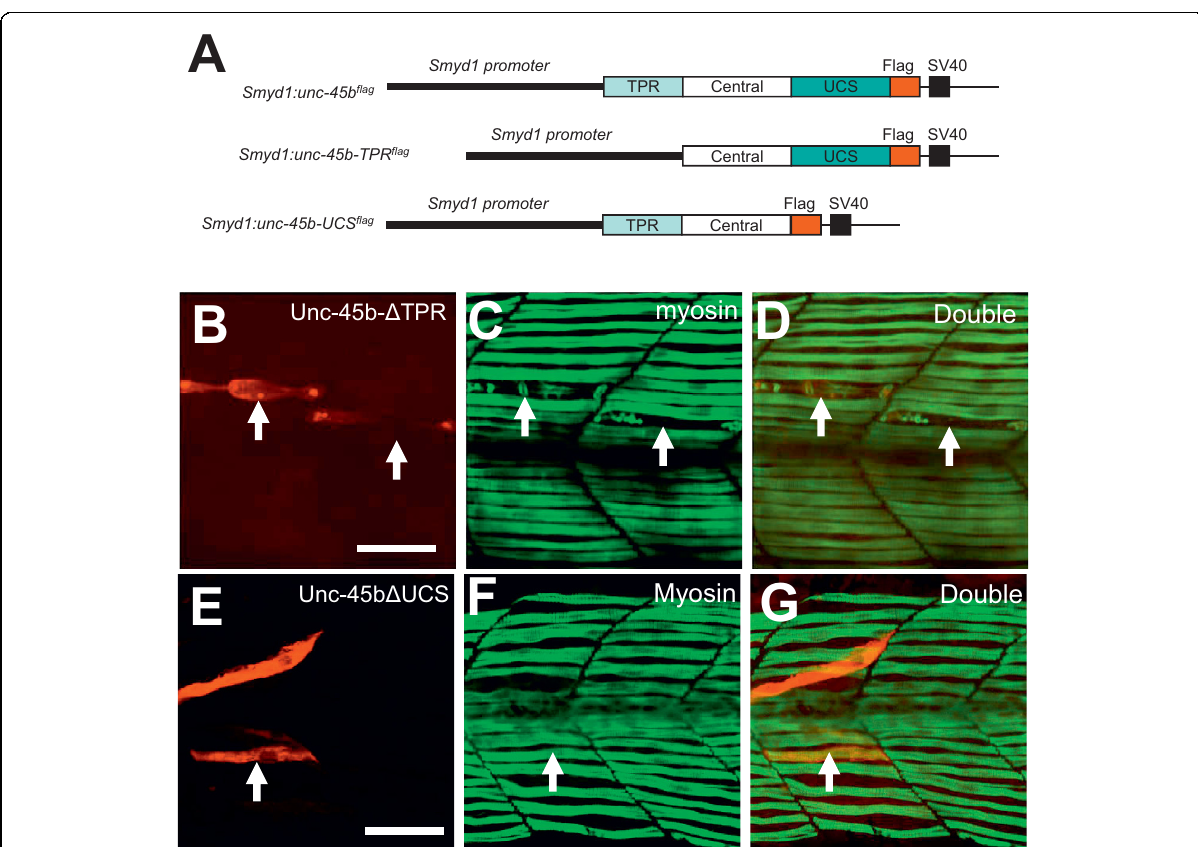
Figure 5 Deletion of the N-terminal TPR domain had no effect on the disruptive activity of Unc-45b on myosin thick filament organization, whereas deletion of the C-terminal UCS domain abolished the disruptive effect of Unc-45b overexpression . A . DNA constructs, smyd1:unc-45b Δ TPR flag and smyd1:unc-45b Δ UCS flag , were generated as minigenes expressing Unc-45b mutant proteins without